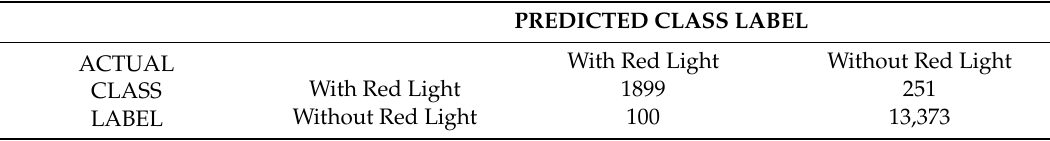
Table 6. Results of classification.